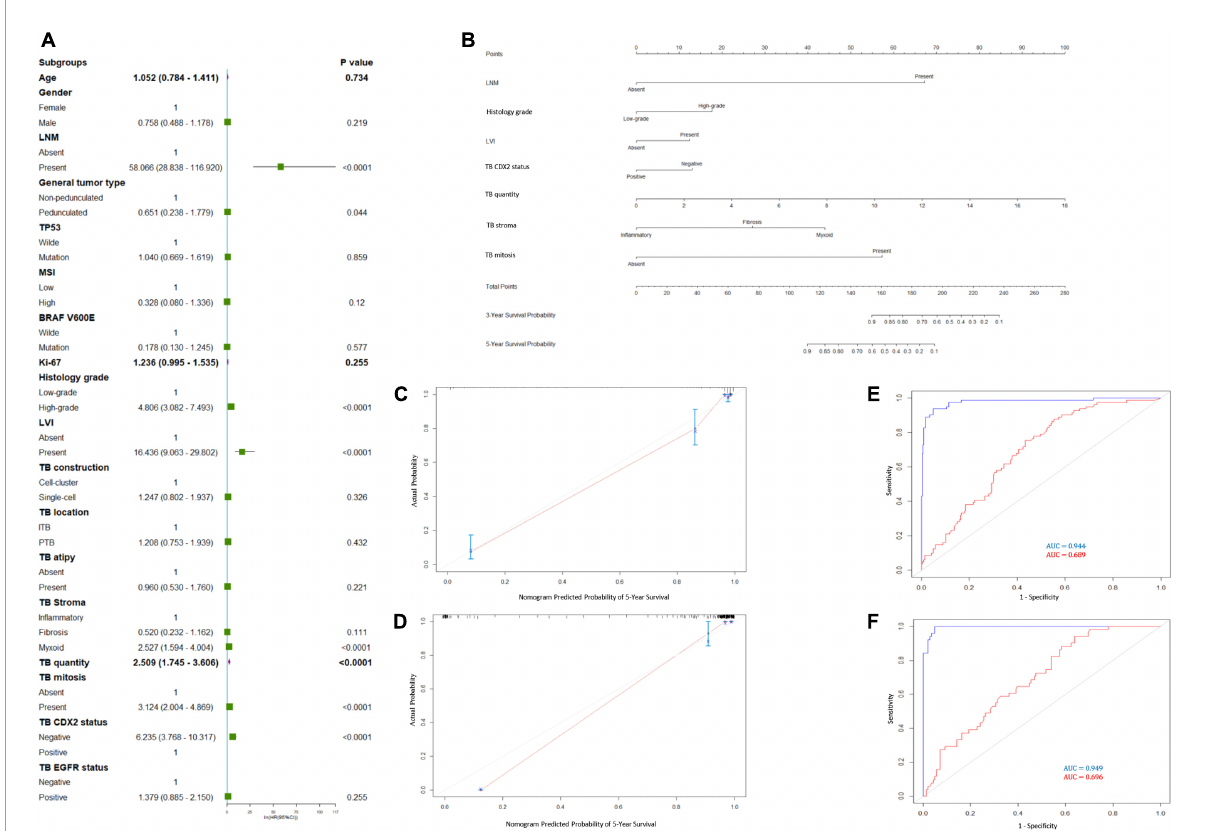
FIGURE3 Prediction model for recurrence-free survival (RFS). (A) Forest plots to decipher the risk factors associated with RFS identified in univariate Cox regression analysis; (B) RFS predictive nomogram. The calibration curve of postoperative RFS in patients with pT1 CRC in the (C) training cohort and (D) validation cohort. Predictive accuracy of RFS-nomogram in the (E) training cohort and (F) validation